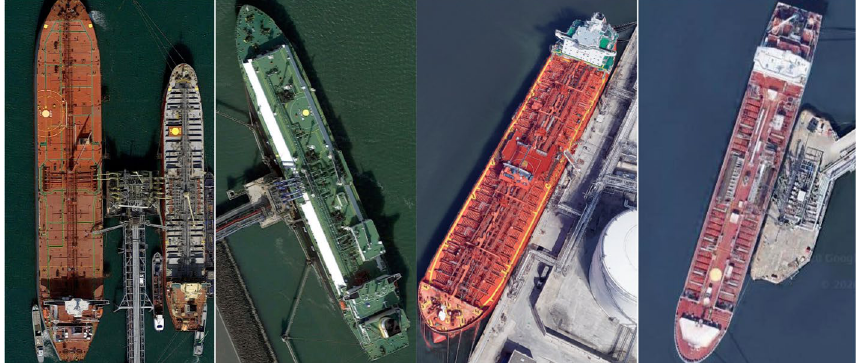
Fig. 1 Examples of tanker mooring situations to illustrate the issue of selecting a connection point. Source : Google